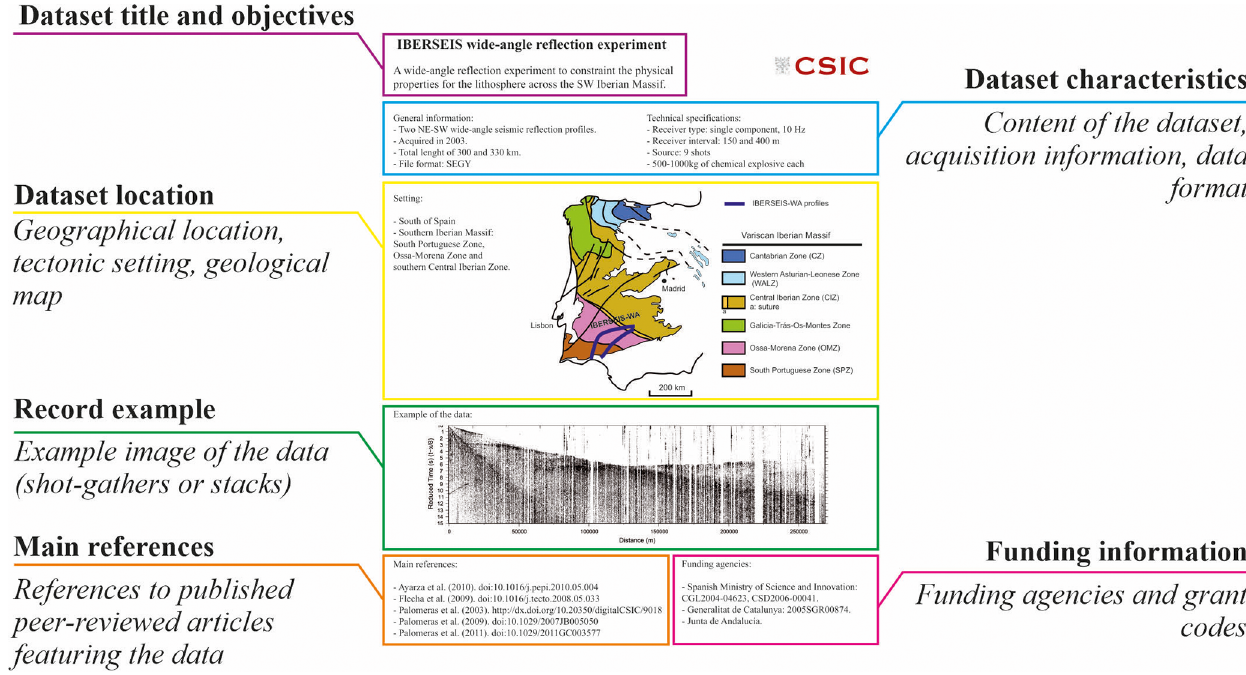
Figure 2. Example of the index card containing the IBERSEIS-WA project (Sect. 5.5.2) information.